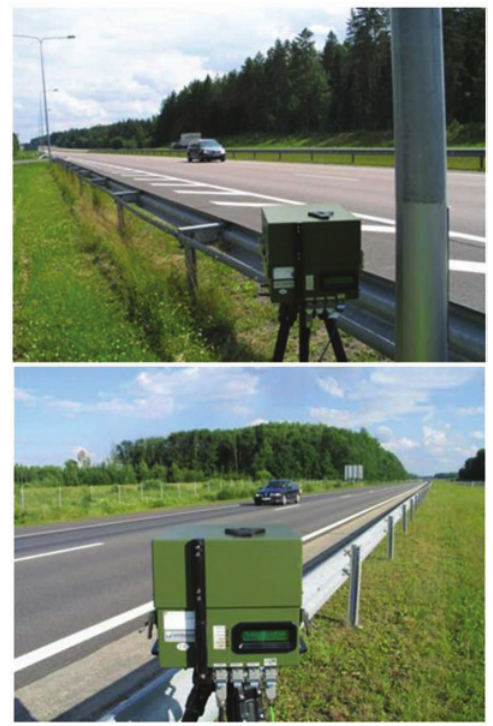
Fig. 2. The sectorial speed enforcement devices on the test section of the road A2 (photo: JSC ATEA )